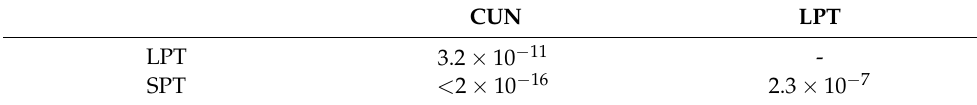
Table 2. Pairwise p -values of Nemenyi [64] test for the normalized makespan